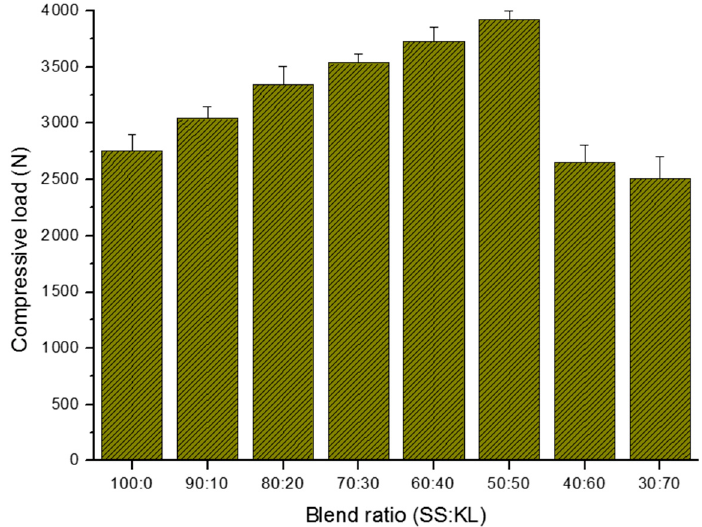
Figure 3. Effect of the SS/KL blend ratio on the compressive load of SS/KL beads.